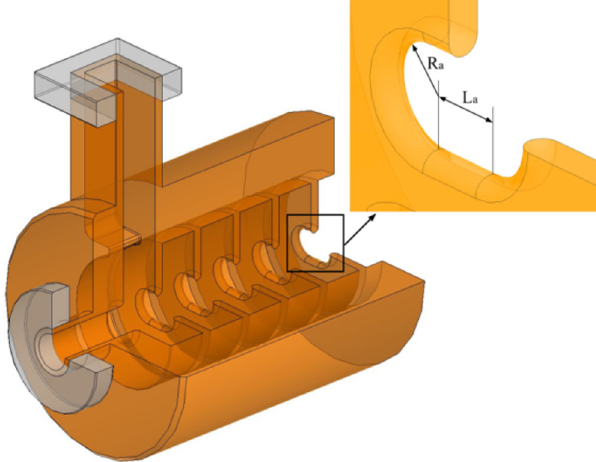
FIG. 25. Observed bunch-shape taken with the streak camera using the OTR. The bunch wave form is reconstructed by stacking ten single-shot wave forms while adjusting each peak value timing. The bunch length is about 300 fs in FWHM.